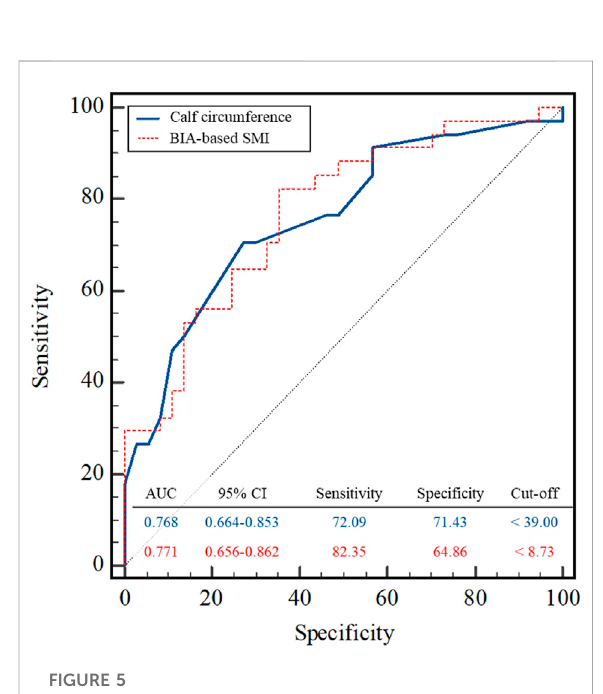
FIGURE 5 ROC curves of the calf circumference and BIA-based SMI in the sarcopenia group in relation to three variables. BIA, bioelectrical impedance analysis; SMI, skeletal muscle mass index; CI; con fi dence